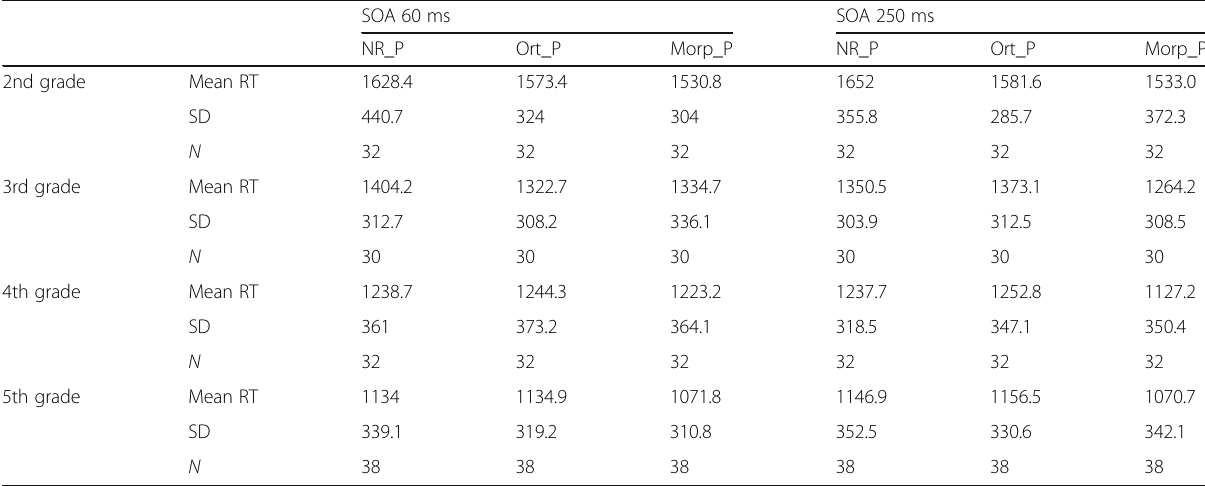
Table 1 Descriptive statistics of lexical decision